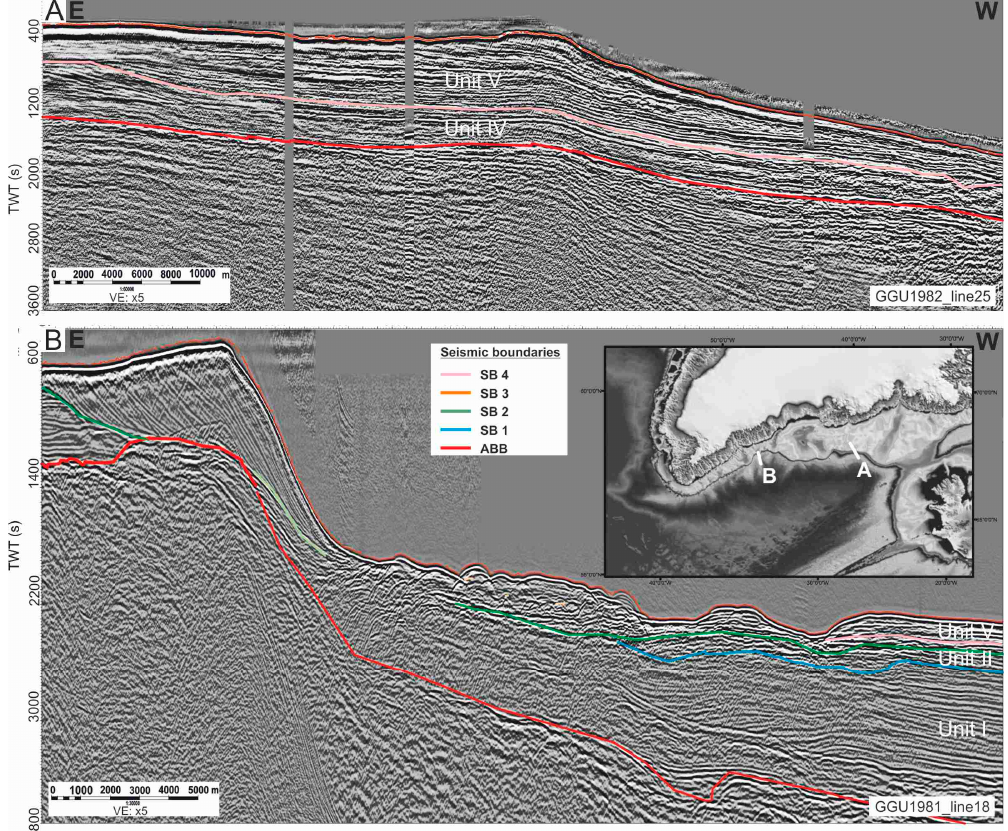
Figure 4. ( A and B ) : Two seismic profiles crossing the shelf and shelf break of the Southeast Greenland margin. Profile ( A ) crosses a gentle slope and profile ( B ) a much steeper slope. The seismic boundaries are indicated in different colours. The map inset indicates the location of both profiles A and B.